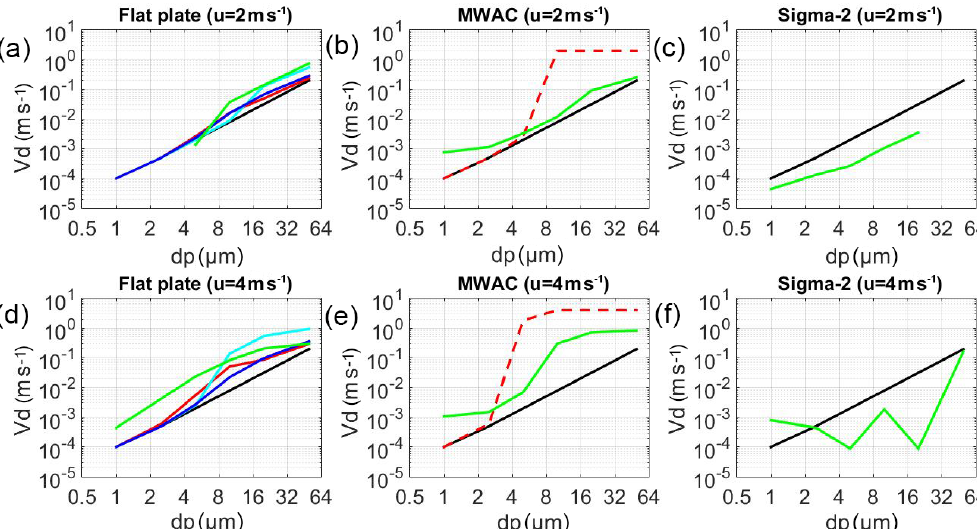
Figure 15. Deposition velocities calculated for different samplers by analytical and CFD approaches. The red curve shows the deposition velocity calculated using the Piskunov model, the dotted red curve shows the combination of the Piskunov and the impaction curve model, the black curve shows the Stokes deposition velocity, the blue curve shows the Noll and Fang model, the cyan curve shows the Zhang model, and the green curve shows the deposition velocity from CFD. Panels (a) – (c) are calculated for 2ms − 1 wind speed and (d) – (f) for 4ms − 1 .